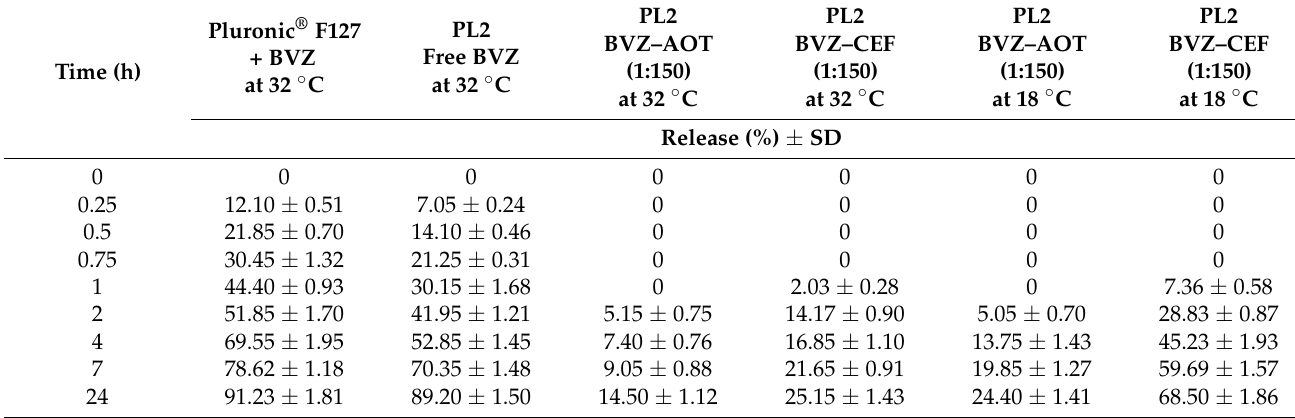
Table 5. Percentage of BVZ ( ± S.D.), free and as ion pair, released from Pluronic ® F127-containing systems vs. time.